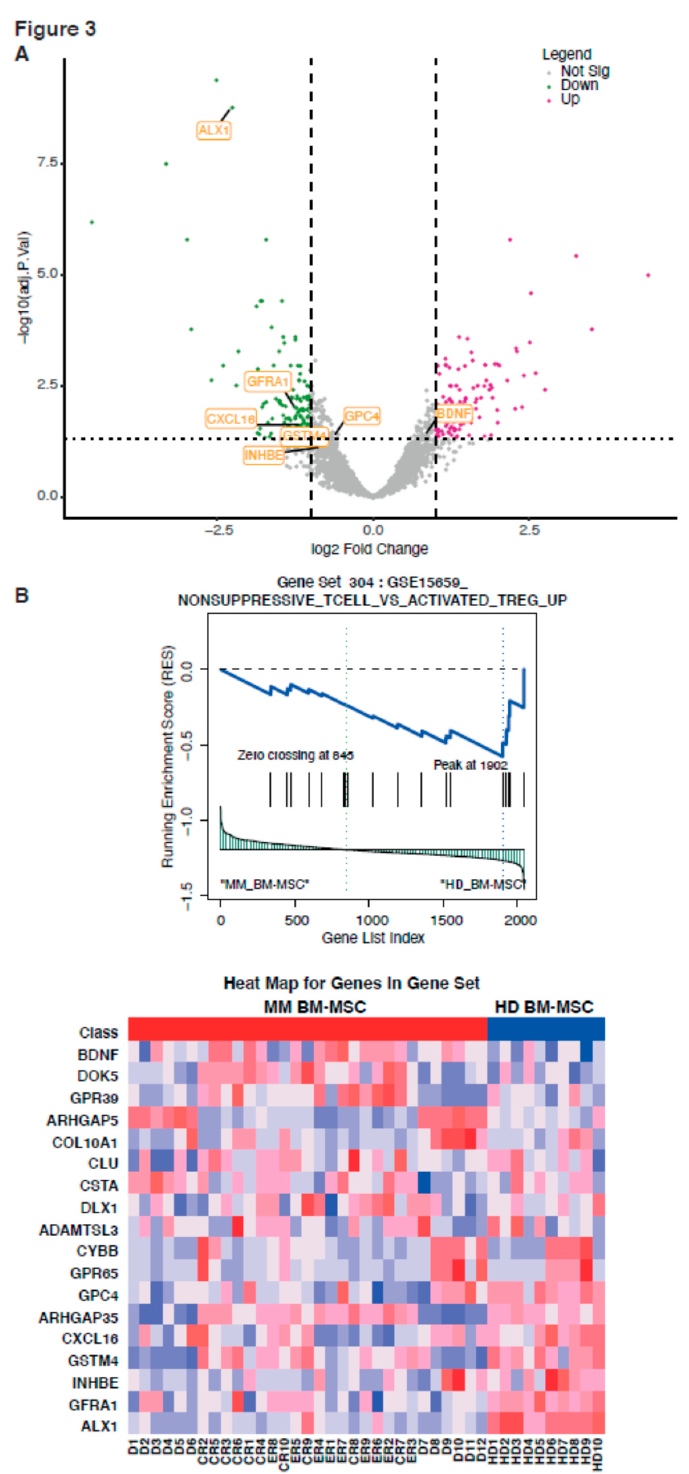
Figure 3. Immunity pathways involved in the di ff erence between MM BM-MSC and HD BM-MSC. Volcano plot of the di ff erentially expressed genes from MM vs. HD BM-MSC, with the impact of genes from the immunity pathway. ( A ) Representative GSEA of MM vs. the HD BM-MSC list of the expressed genes with the pathway of Gene Set 304 (GSE15659 non-suppressive T cell vs. activated T reg). Immunity pathway is downregulated by MM vs. HD BM-MSC. The corresponding heatmap of the represented genes is also shown ( B ).